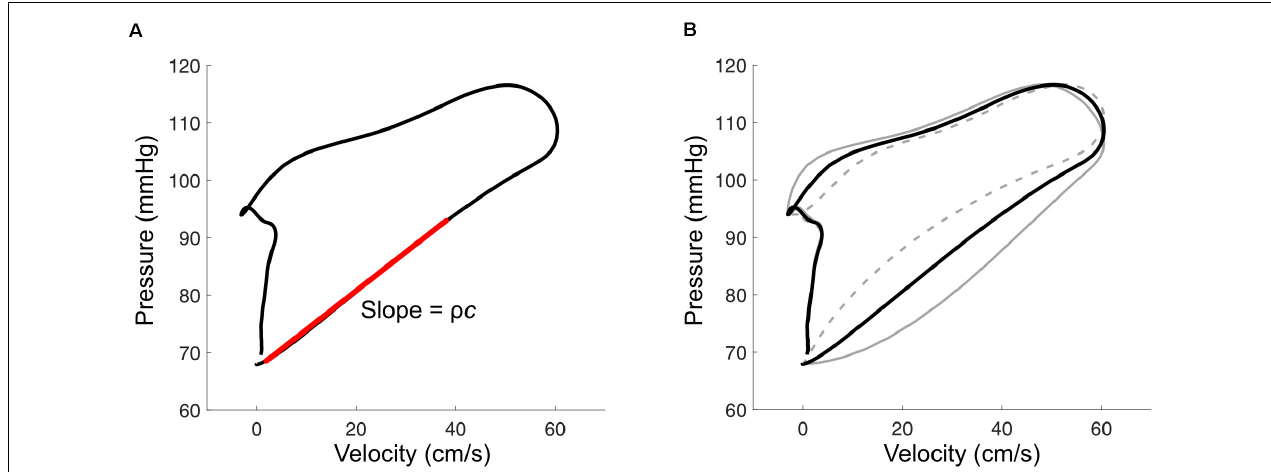
FIGURE 5 | (A) With the pressure-velocity (PU) loop method, wave speed ( c ) is calculated from the slope of the early-systolic PU relation (red line), where ρ is blood density. (B) Misalignment of pressure and velocity signals introduces curvature in the early systolic relation. This example shows the effect of velocity leading or lagging pressure by 10 ms (solid and dashed gray lines,